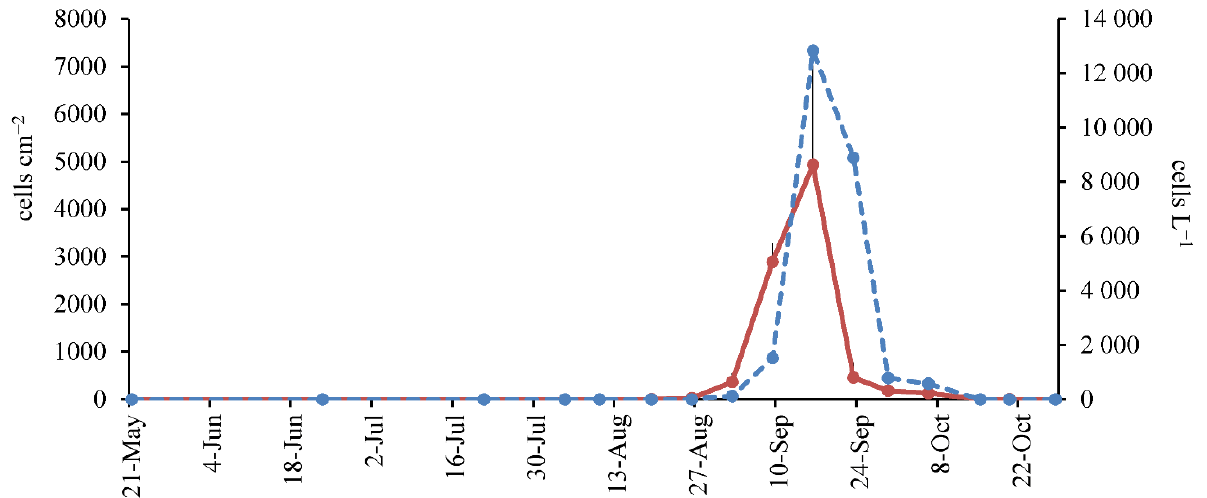
Figure 3. Abundance pattern of Ostreopsis cf. ovata on seaweeds (bold line, cells cm − 2 , left y-axis) and in the water column (dotted line, cells L − 1 , right y-axis) at the Passetto station. Error bars indicate standard deviation.